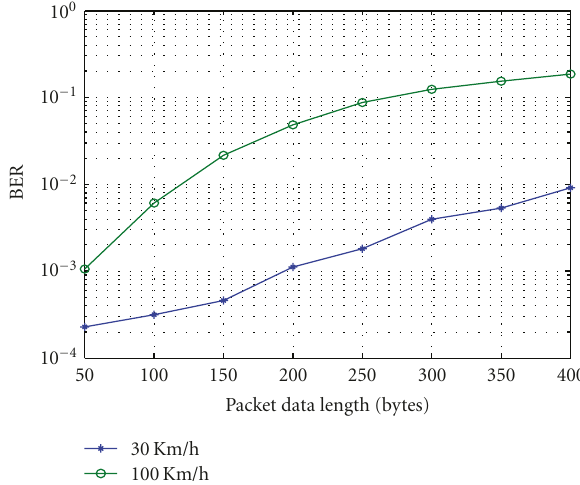
Figure 11: BER performance according to packet length (Eb/No = 10 dB).